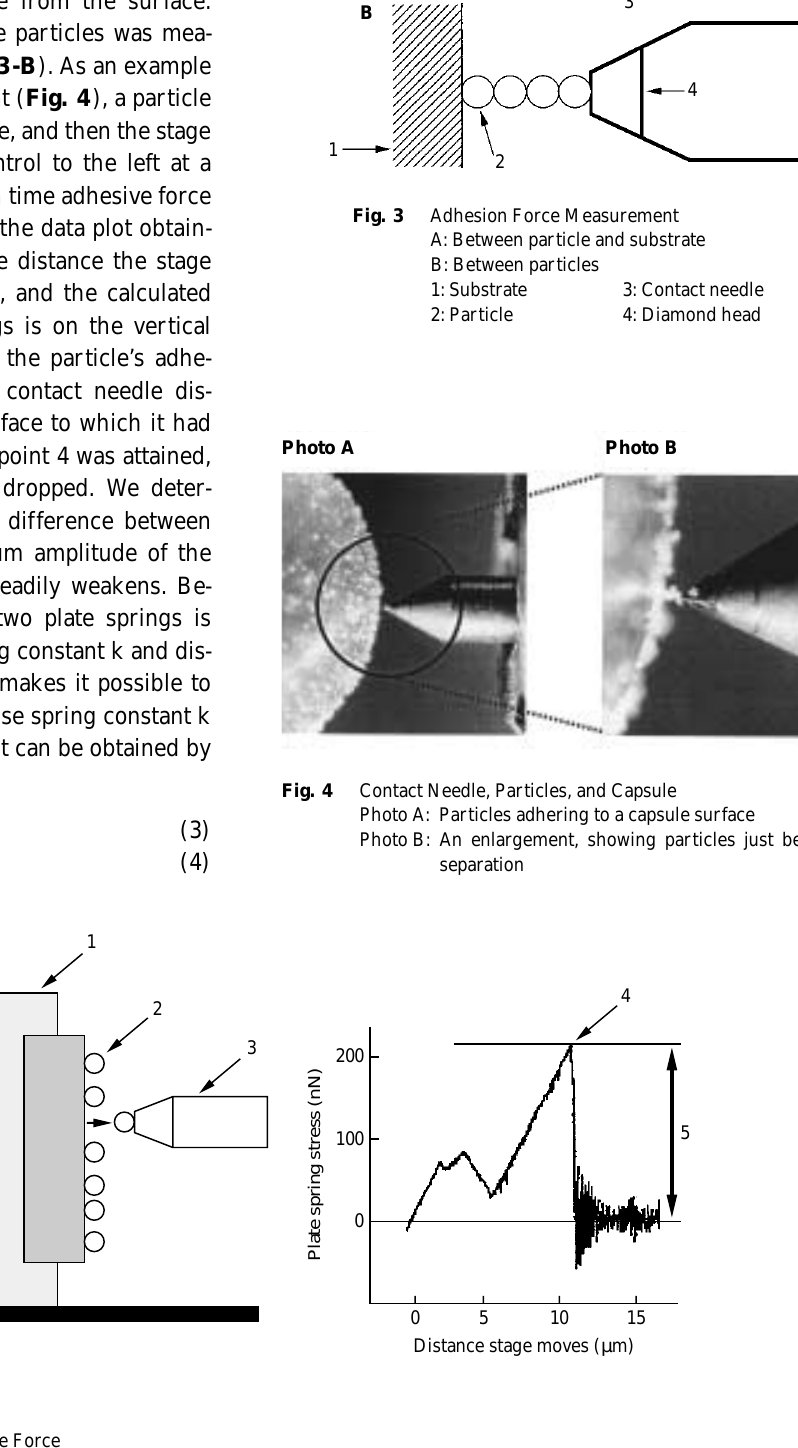
Fig. 5 Separation and Adhesive Force 1: Stage 2: Particle 3: Contact needle 4: Adhesive force peak 5: Net adhesive force 6: Distance stage moves